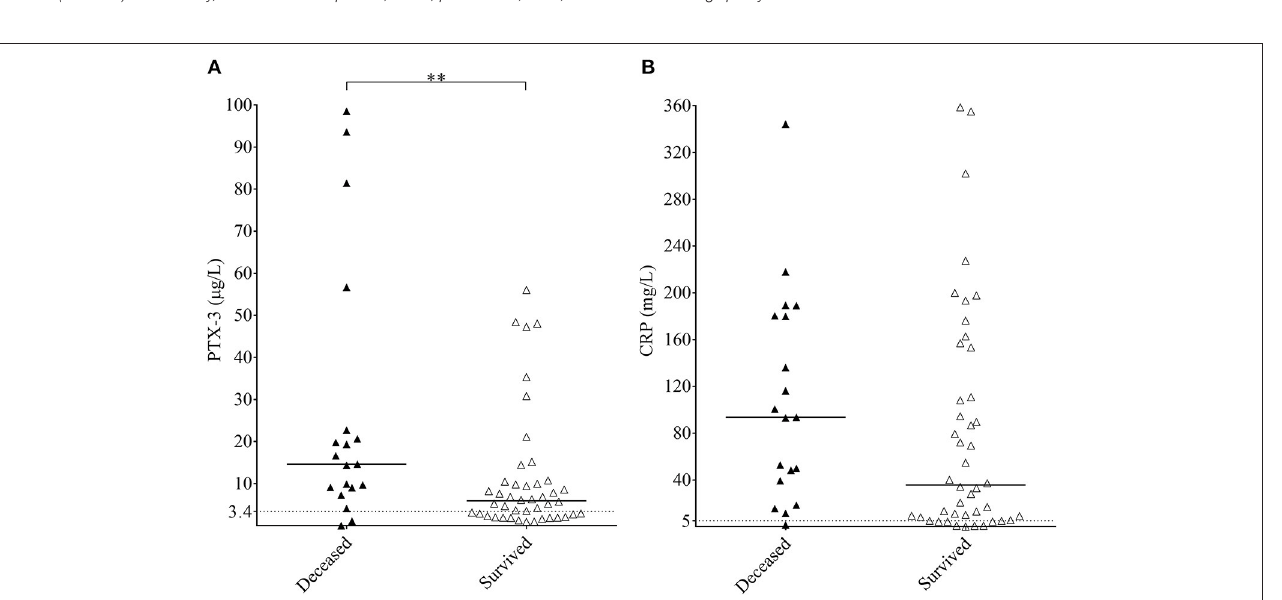
SpearmancorrelationanalysisofPTX3andCRPlevelstolaboratorymarkersofhemolysis,thrombocytopeniaandkidneydamage,characteristictoacutephase-TMA.Statisticalanalysis was performed by the Spearman correlation test, obtained r and p-values are indicated by each parameter, with the number of pairs analyzed. Significant correlations are highlighted in bold. Please note that blood count and chemistry data were not accessible by all the enrolled patients, therefore the correlation analyses might include less than the total number of